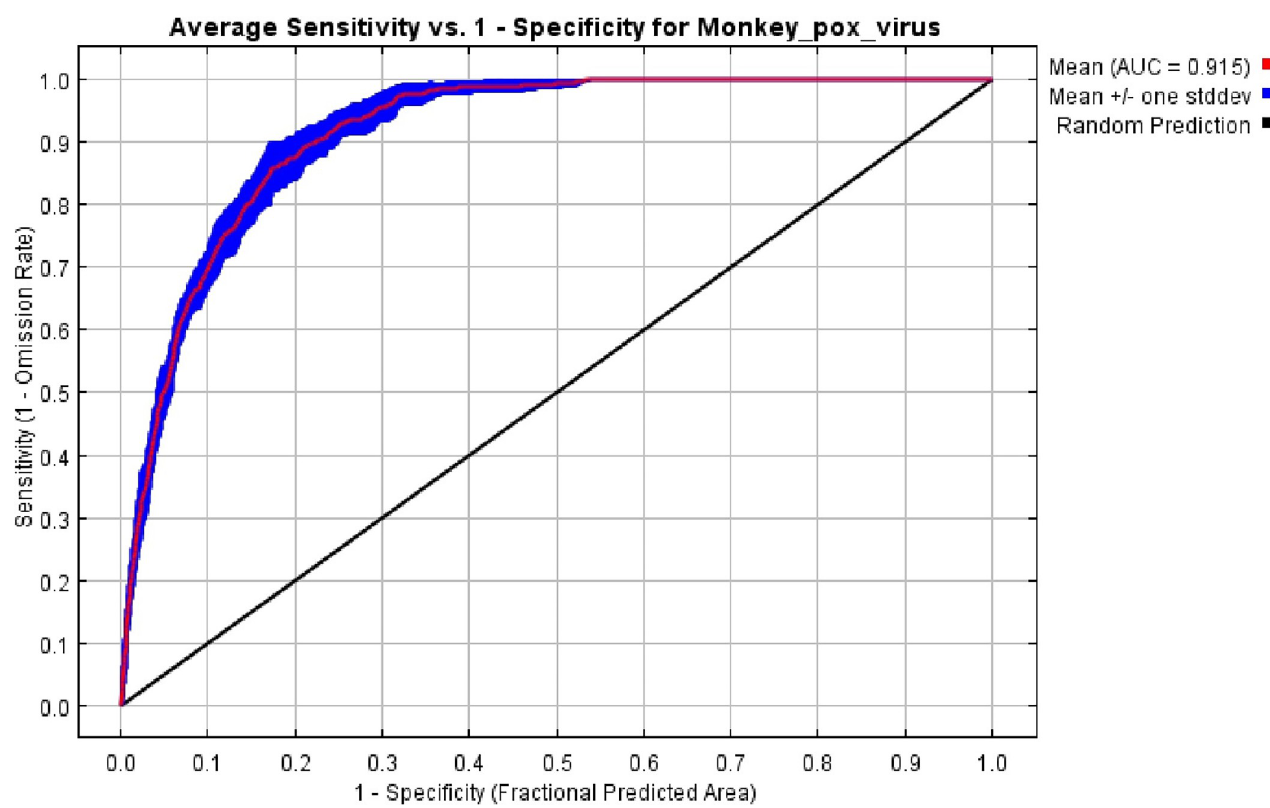
Fig 2. Average receiver operating characteristics [36] and related area under the curve (AUC) of the 100 bootstrap replicates.